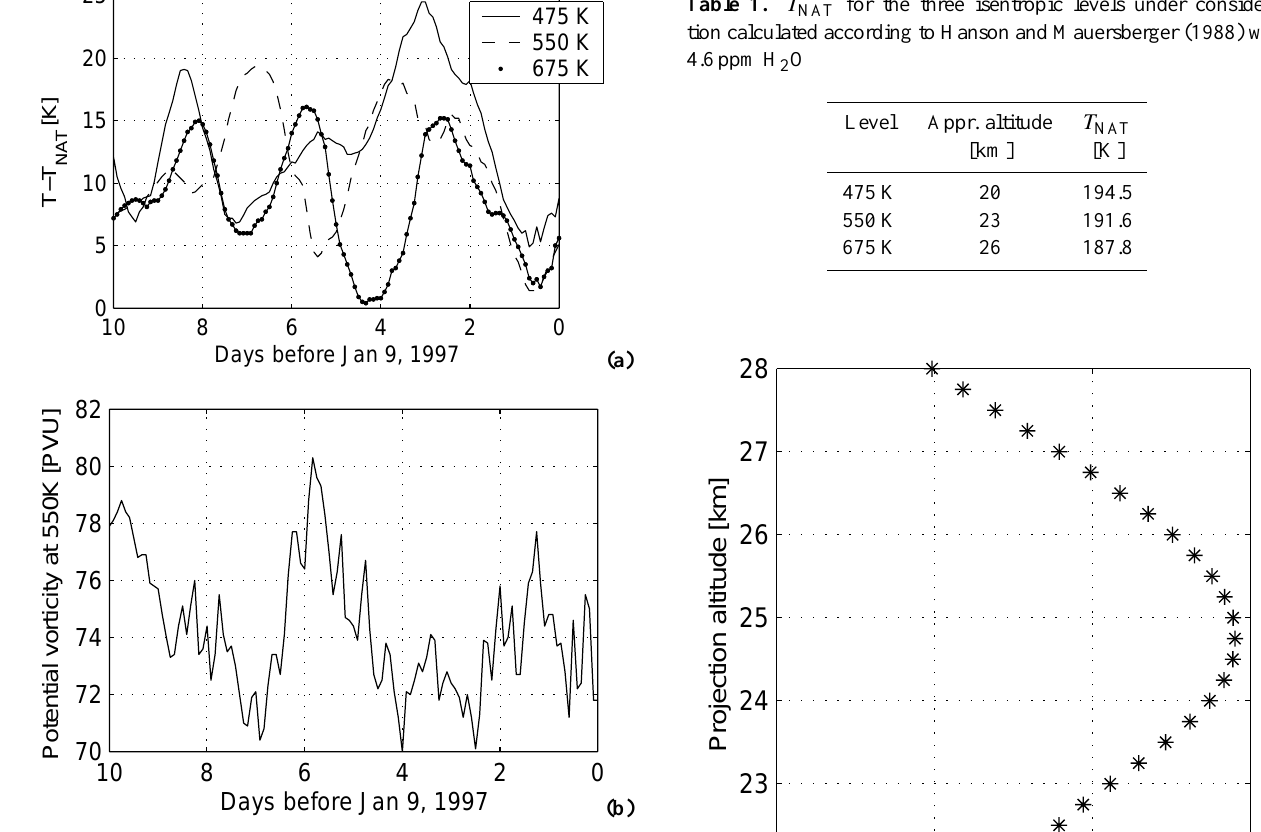
Table 1. T NAT for the three isentropic levels under considera- tion calculated according to Hanson and Mauersberger (1988) with